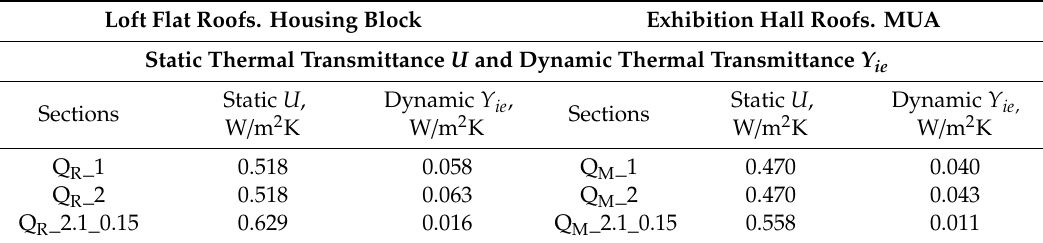
Table 8. Static and dynamic thermal transmittance